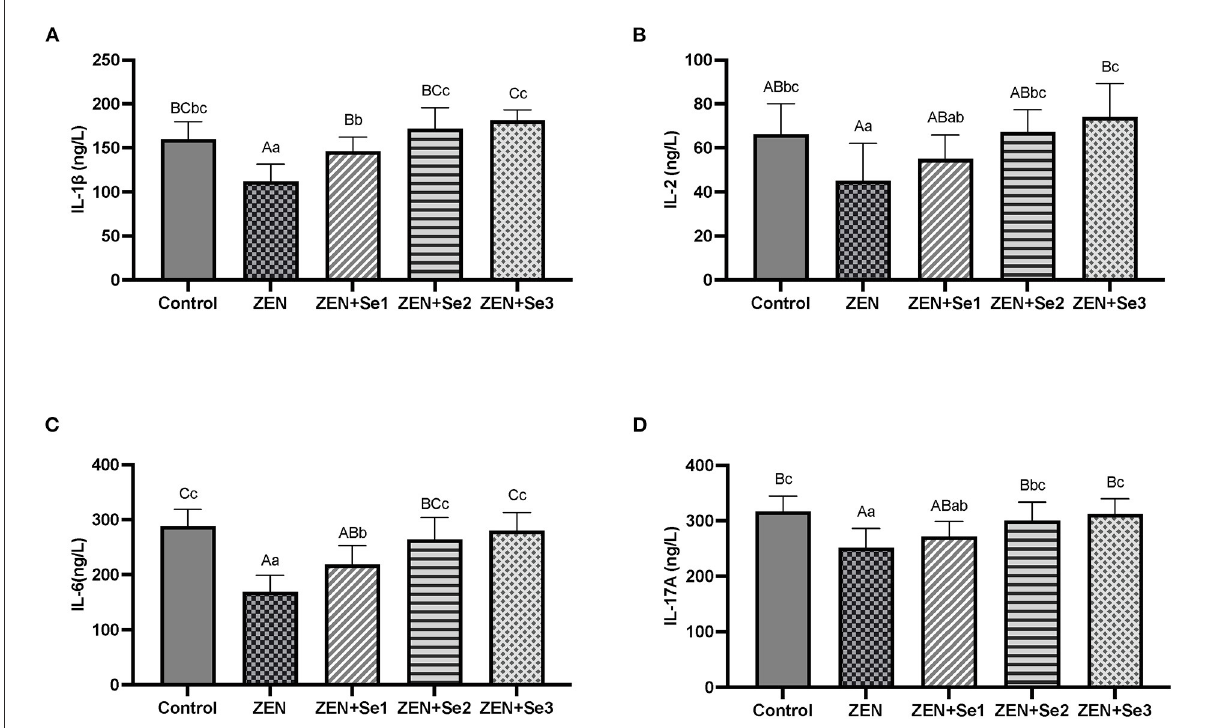
FIGURE3 Effects of SC on the plasma contents of ILs induced by ZEN in mice: (A) IL-1 β ; (B) IL-2; (C) IL-6; (D) IL-17A. Different capital letters (lowercase letters) in the column chart indicate a significant difference at the 0.01 (0.05) level.